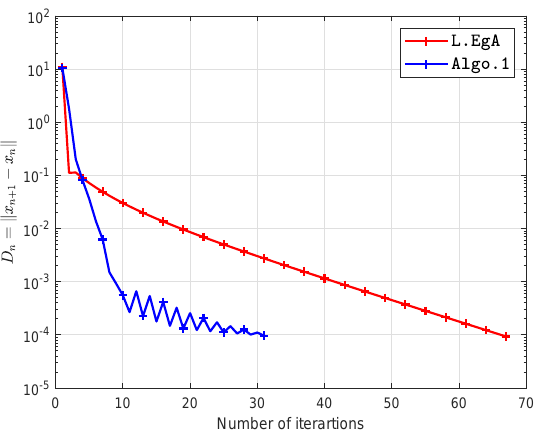
Figure 13. Example 4 while u 0 = ( 10,10 ) .